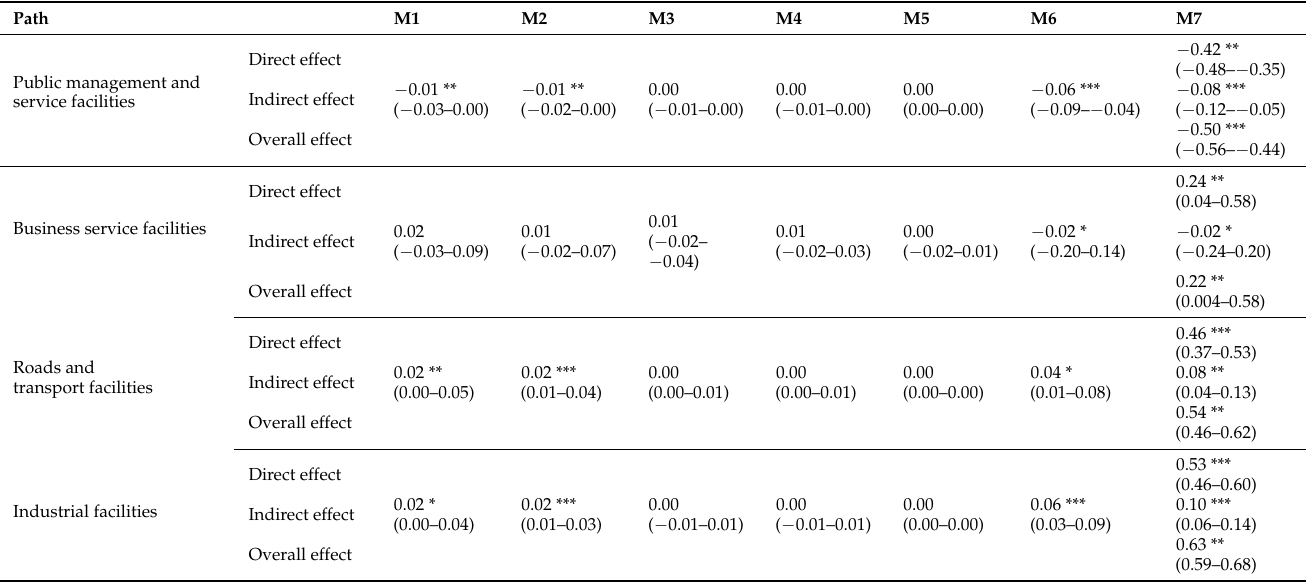
Table 3. Association between built environment types and the prevalence of hypertension: serial mediation